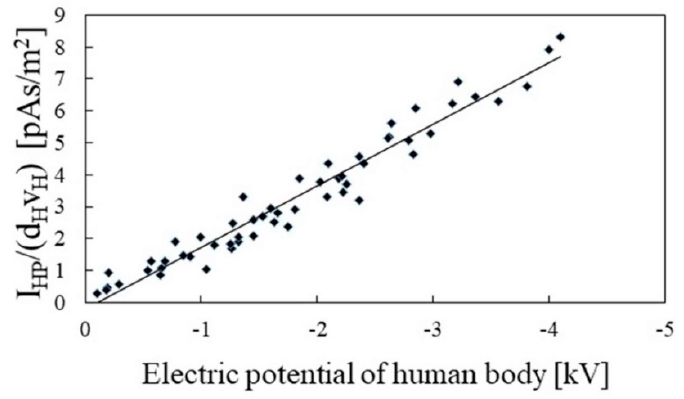
Figure 8. Human body potential dependence of the value of the peak value of the electrostatic induction current ( I HP ) trace induced by the movement of the palm divided by the product of the palm velocity ( v H ) and detection distance ( d H ).